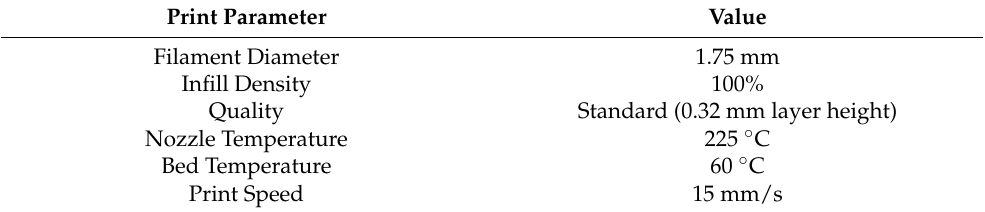
Figure 1. Specimen preparation: ( a ) variables of the specimens; ( b ) a specimen representation in the Cura Lulzbot ® Edition software; ( c ) printing a specimen using the LulzBot Taz Mini 2 ® . Table 2. Print parameters. Table 2. Print parameters.